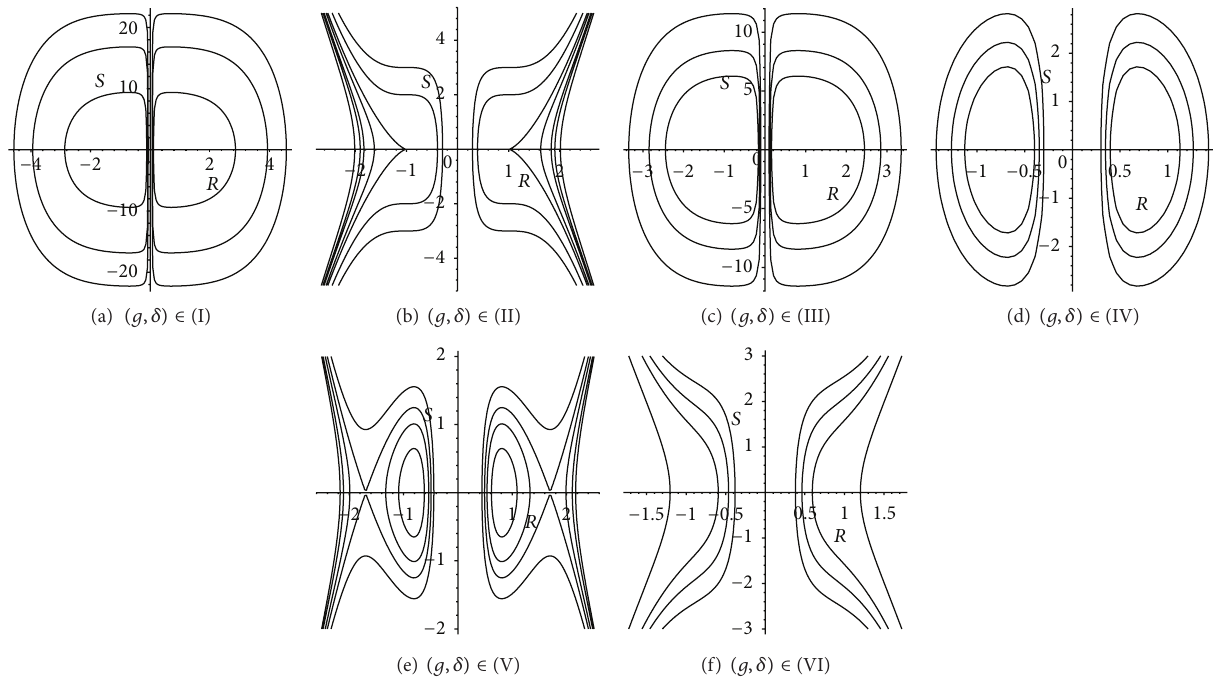
Figure 2: The phase portraits of